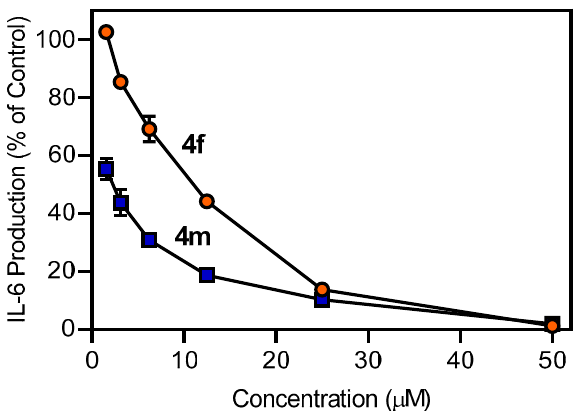
Figure 3. Effect of the compounds 4f and 4m on IL-6 production by human MonoMac-6 cells. MonoMac-6 cells were pretreated with the indicated compounds or DMSO (negative control) for 30 min followed by addition of 250 ng/mL LPS or buffer for 24 h. Production of IL-6 in the supernatants was evaluated by ELISA. The data are presented as the mean ± S.D. of triplicate samples from one experiment that is representative of three independent experiments.